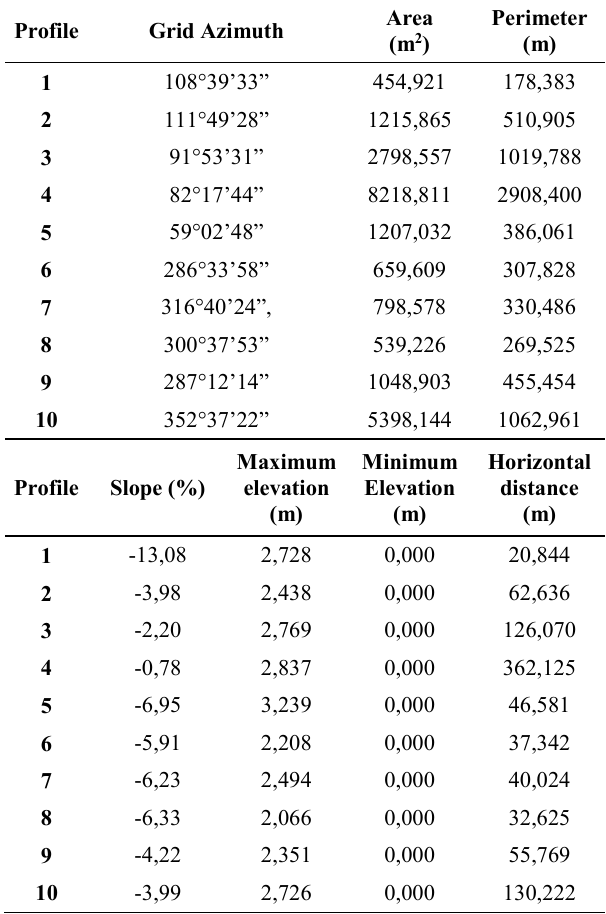
Table 4: Beach Profile